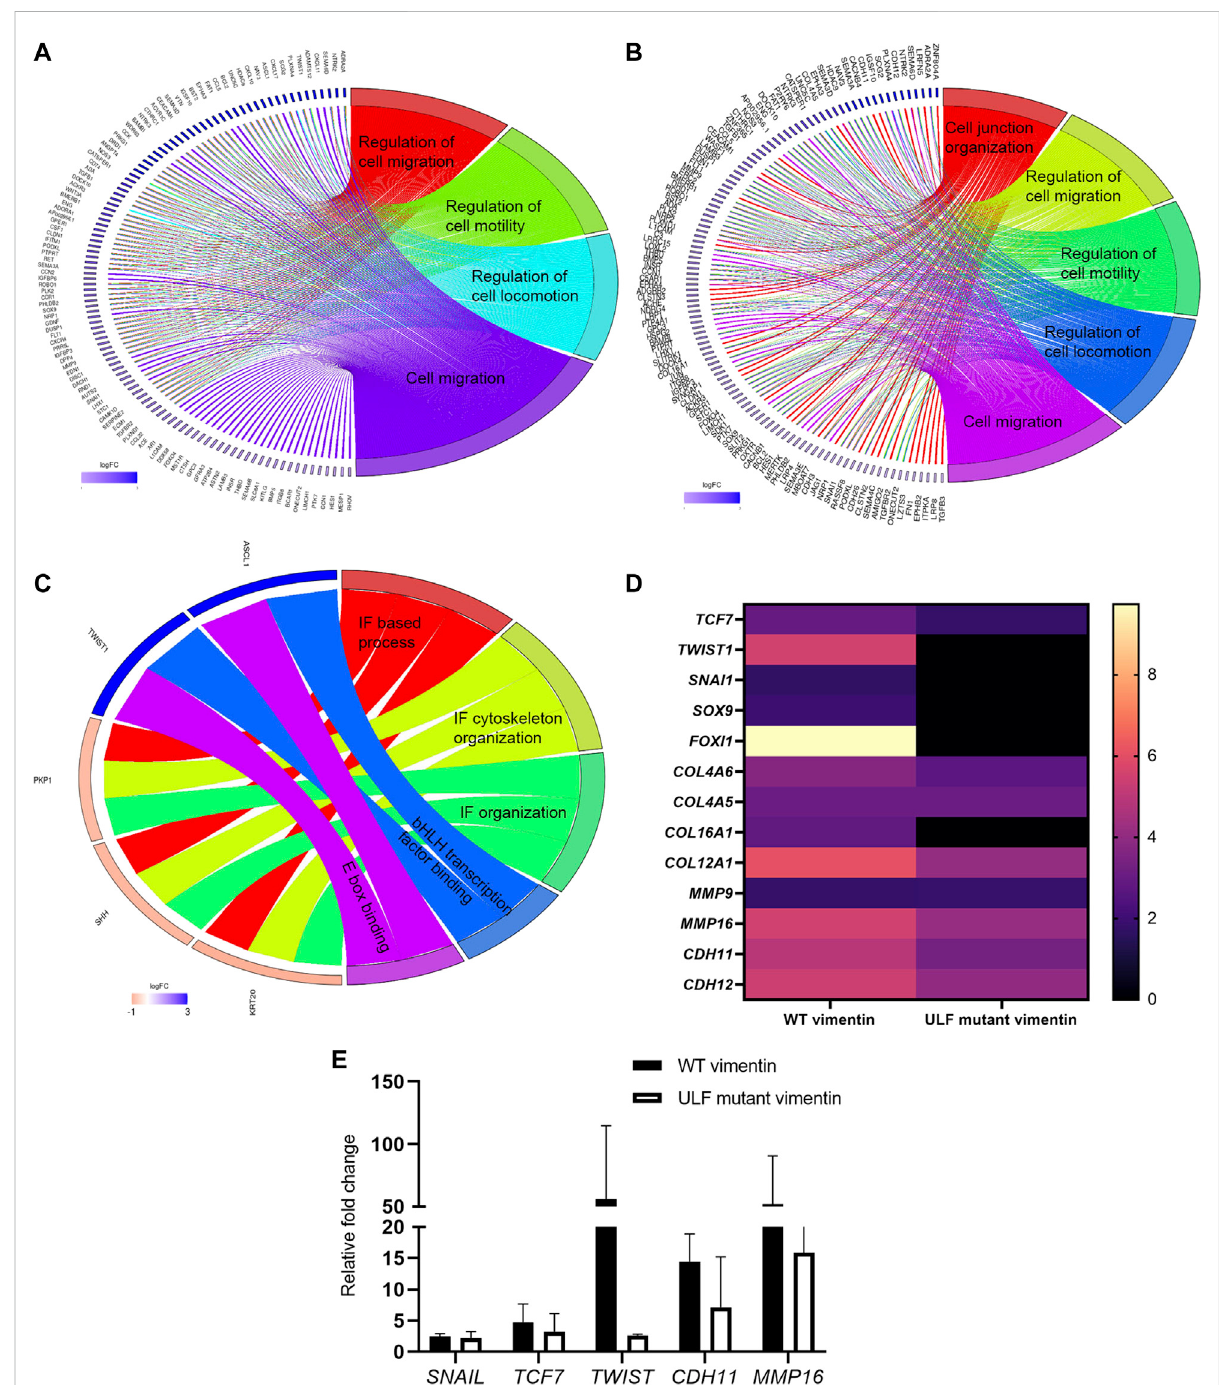
Upregulation of TWIST1 requires WT vimentin. Circos plot representation of signi fi cantly enriched pathways linked with (A) WT vimentin vs. uninduced; (B) ULFmutantvimentinvs.uninduced; (C) WTvimentinvs.ULFmutantvimentin.Theribbon/arcthatoriginatesfromdifferentgenesand terminates at associated pathways demonstrates the connectivity of genes and overrepresented pathways; (D) Heatmap shows the fold change values of transcription factors and few of the mesenchymal markers in cells expressing WT or ULF mutant vimentin. (E) Graph depicts the relative fold change values of genes obtained by real time PCR ( n = 3). 18S rRNA was used as the internal